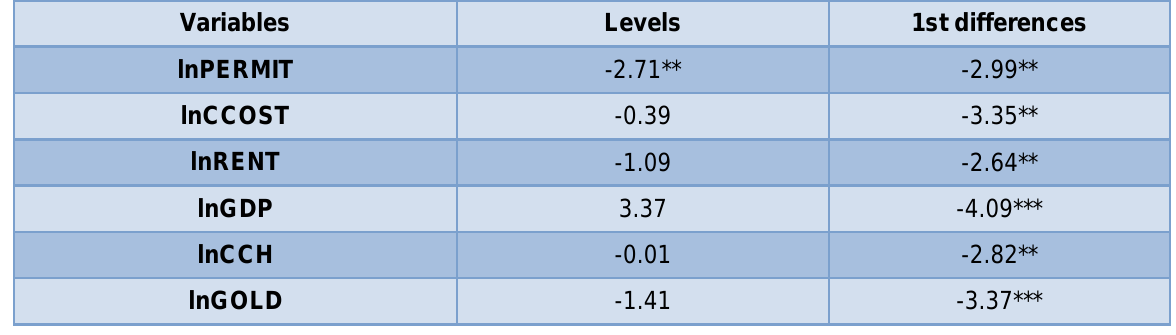
Table 3 ADF t-test for stationarity